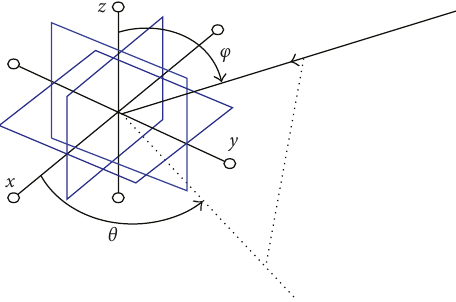
Figure 2: Coordinate system and angle